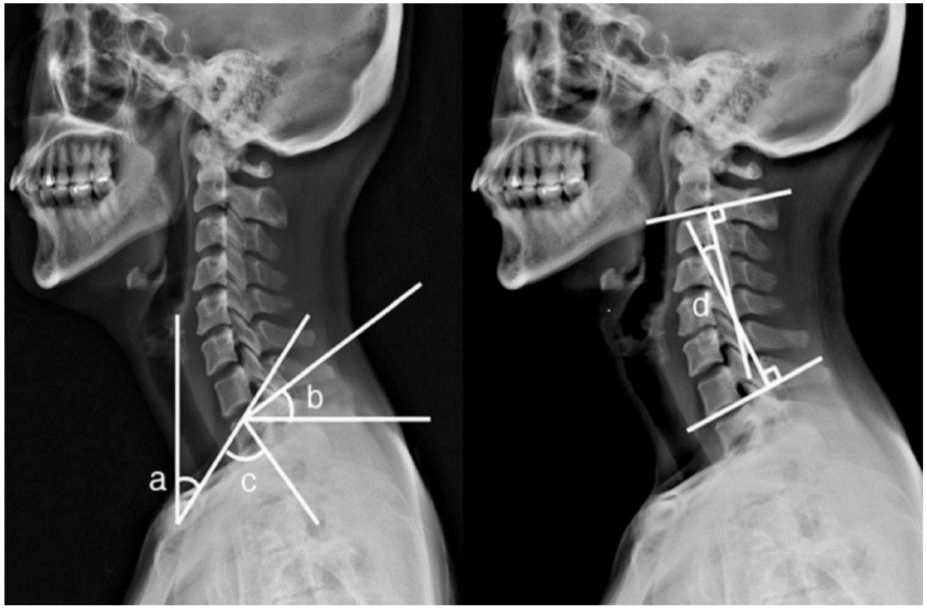
Figure 2. Parameters of cervicothoracic spine segments: (a) neck tilt; (b) T1 slope; (c) thoracic inlet angle; (d) C2-7 Cobb’s angle [20] (open